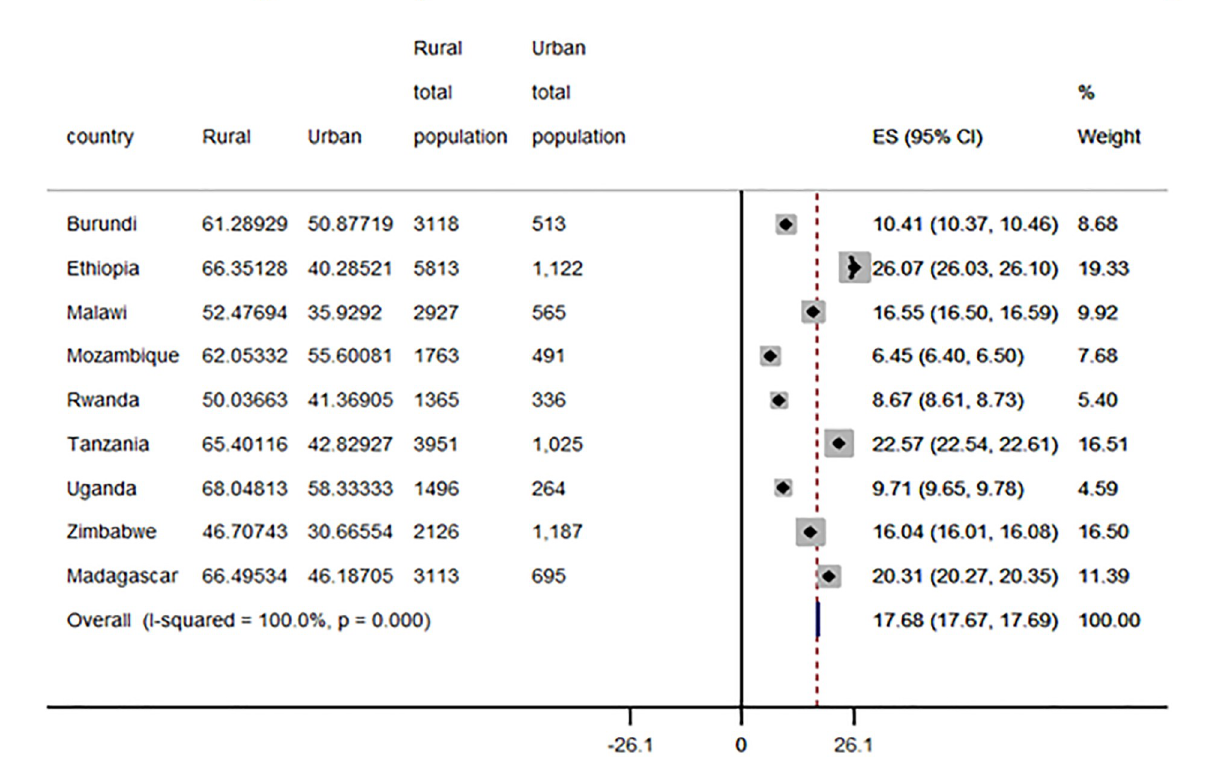
Fig 2. Forest plot of risk differences of high-risk fertility behavior among between rural and urban reproductive-age women in East Africa countries.